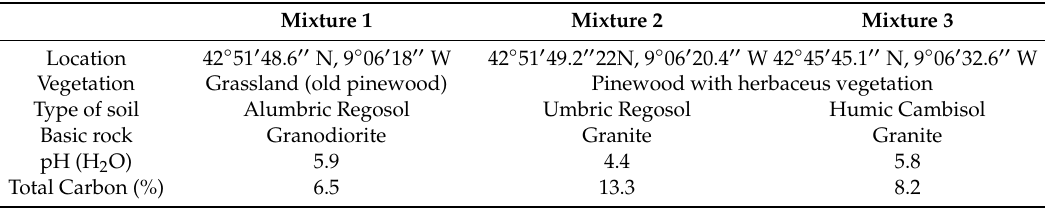
Table 2. Characteristics of soil sampling